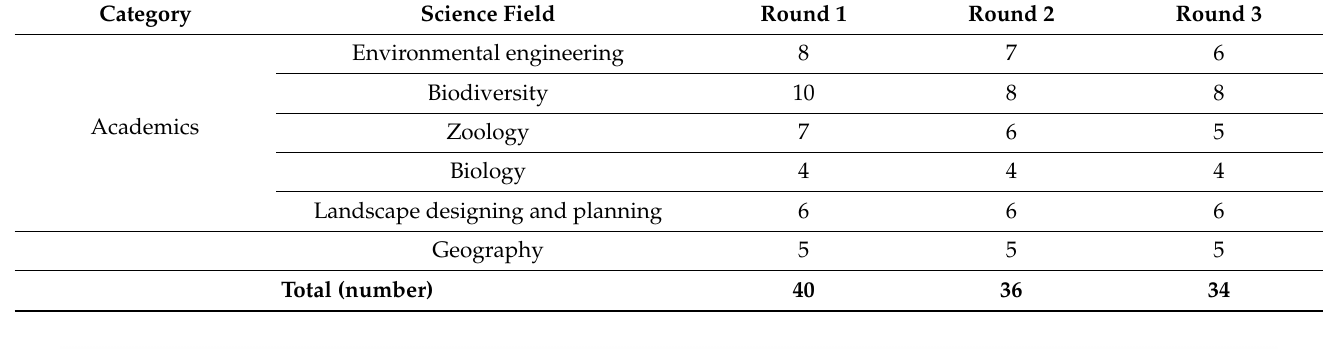
Table 2. Number of experts who participated in the Delphi study.